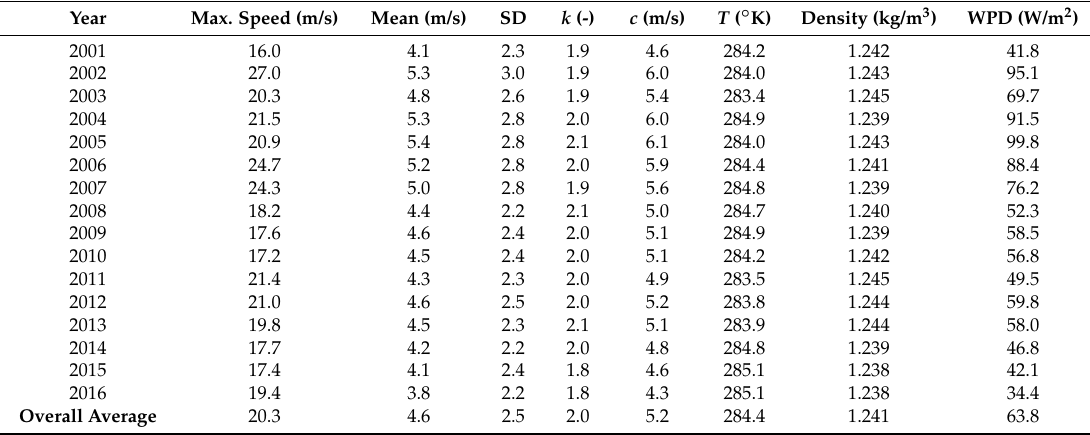
Table 4. Long term wind data analysis of Seo-San at 10 m from local ground.